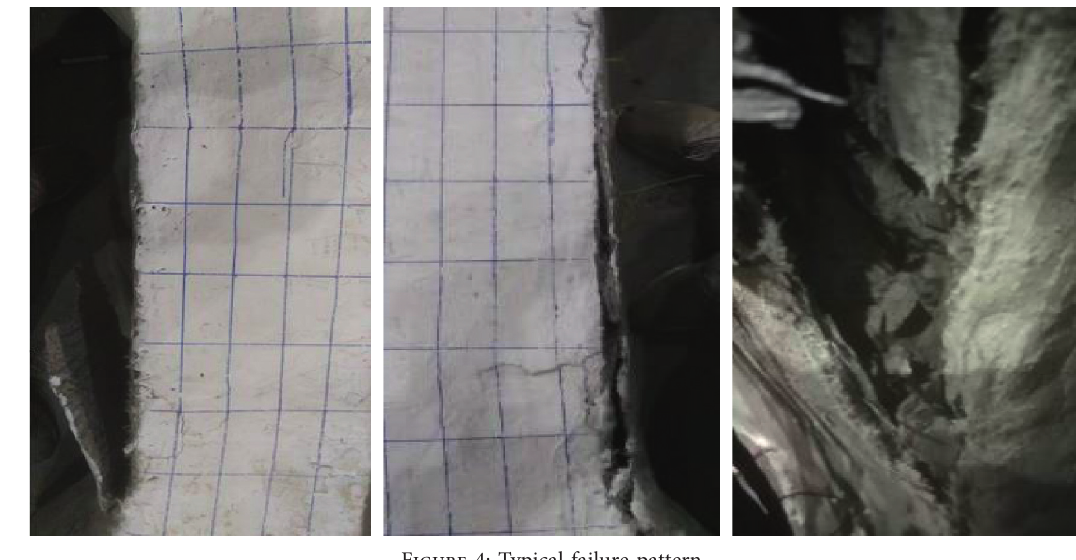
Figure 4: Typical failure Table 4: Test results.